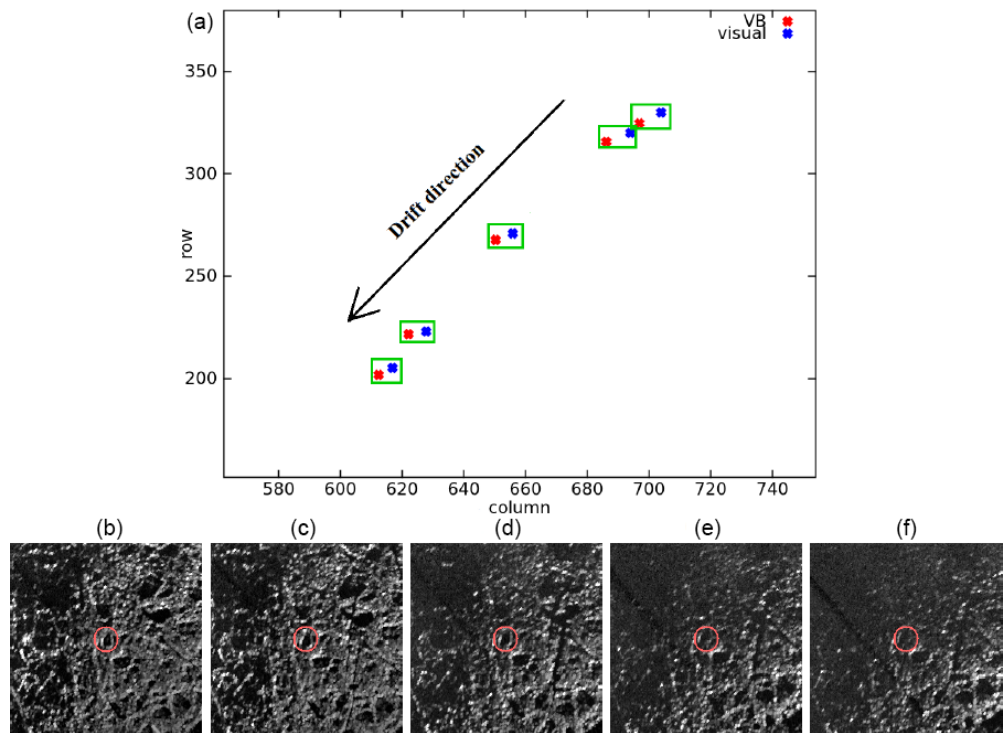
Figure 18. An example of manual VB pixel location estimation and VB location defined by the algorithm with a time step of 200min (case A). The locations are shown in (a) : the red dots indicate the VB centre location, the blue dots the selected and tracked feature location, and the corresponding pairs have been marked with the green rectangles. The VB areas (red circles) in the radar imagery with some background included at the given time instants are shown in time order from left to right in (b) – (f)